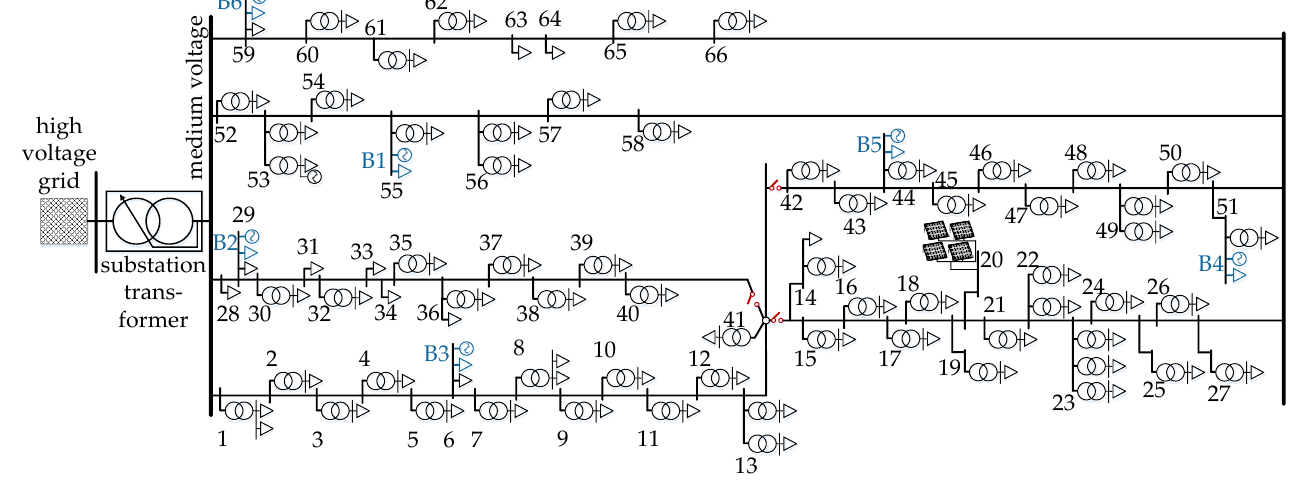
Figure 8. Maxima (absolute) active (blue) and reactive power behavior (orange) at load buses of the medium-voltage test system (non-simultaneous).